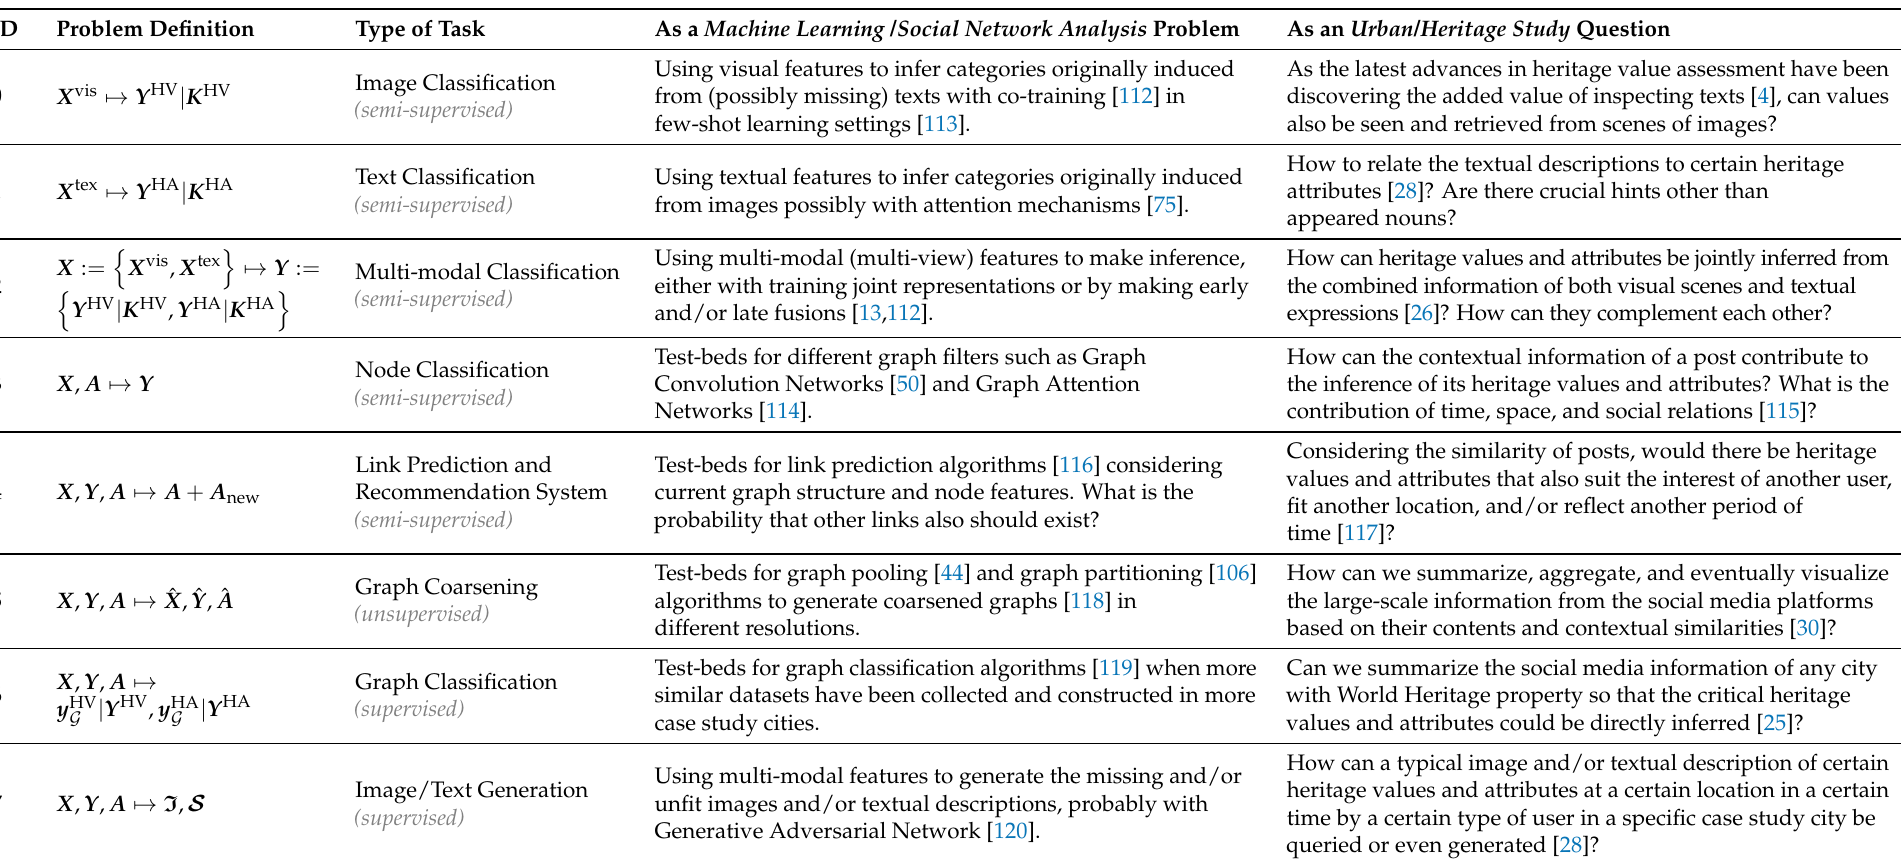
Table 8. A few provisional tasks with formal problem definitions that could be performed. Potential scientific and social relevance for the Machine Learning community, and urban and/or heritage researchers, respectively, are given. The gray texts in the third column give a high-level categorization for each specific type of task in the context of machine